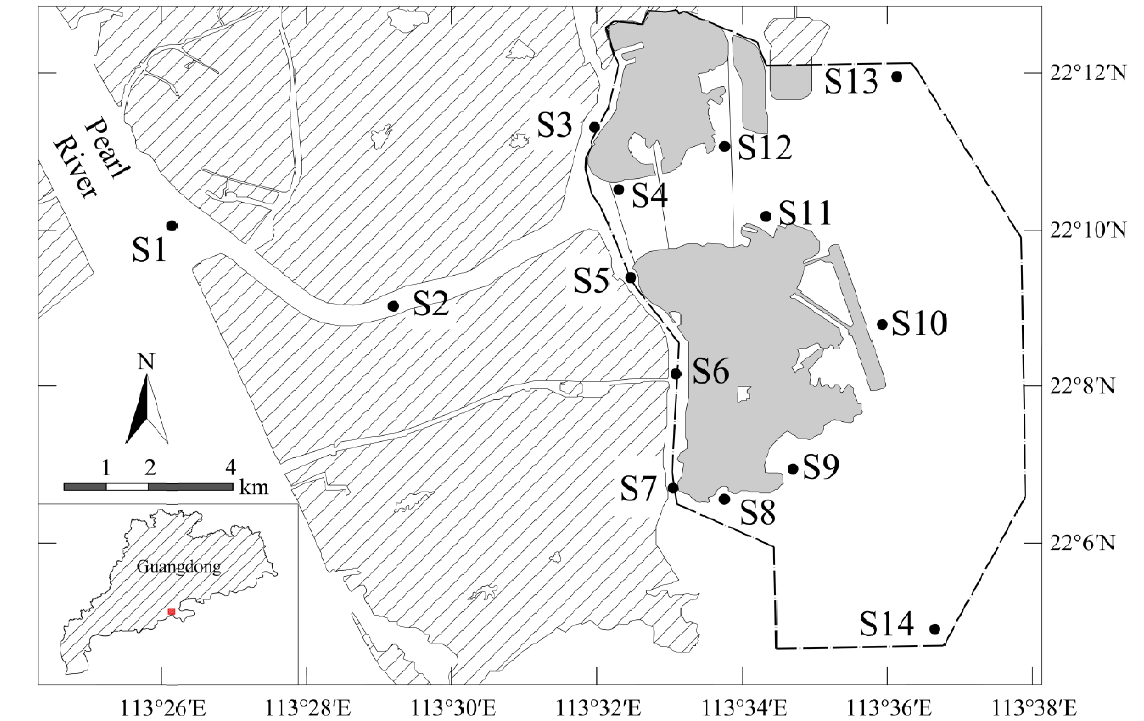
Figure 1. Map of the study area showing location of sampling sites.